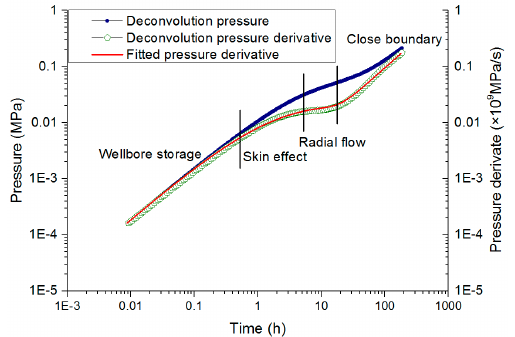
Figure 3. H3-1 pressure drop well-test double logarithmic curves.